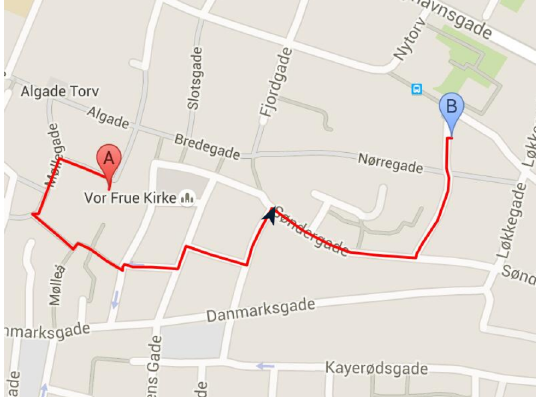
Figure 4. Map-basednavigationusingmapprovidedby Google Maps showinguser’s